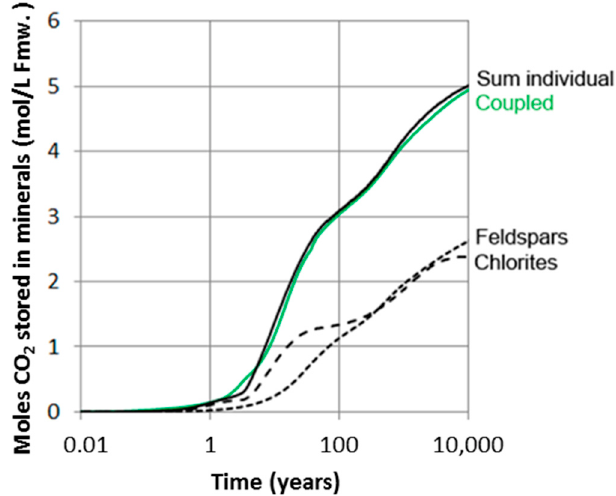
Figure 9. The amount of dawsonite formed with varying amount of plagioclases lithic rock fragments (low-reactive) or as separate detrital crystals (high-reactive) over ( a ) 100 years, and ( b ) 10,000 years.